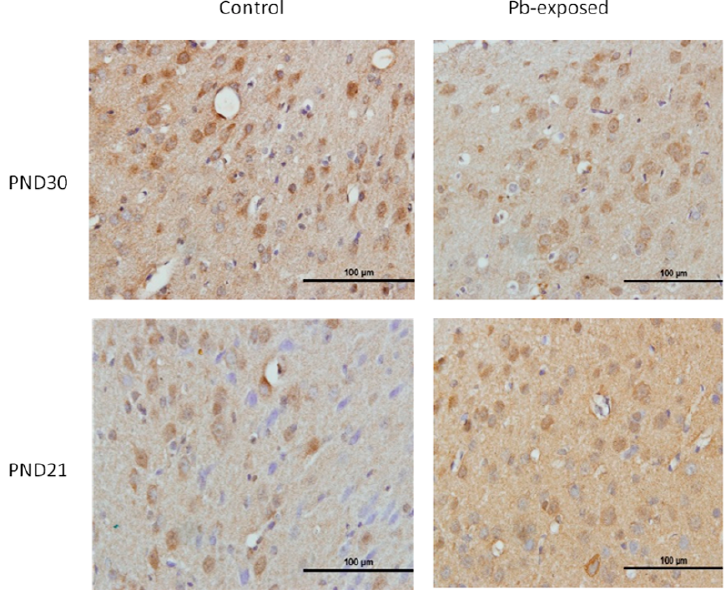
Figure 3. Immunohistochemistry photomicrographs showing the effects of Pb exposure on the expression of 1- α -hydroxylase in cerebral cortex of PND21 and PND30 rats. Sections ( n = 3) counterstained with Mayer’s hematoxylin were photographed with oil immersion lens.